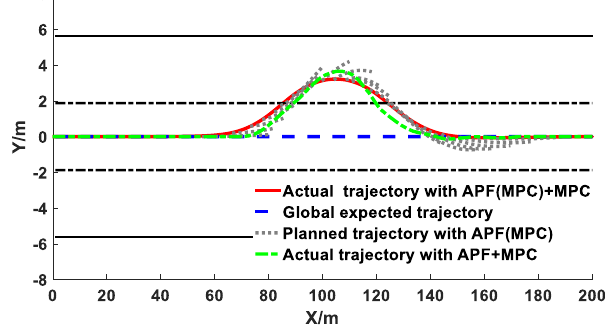
Figure 16. Co-simulation results of obstacle avoidance trajectory planning under 60 km/h.